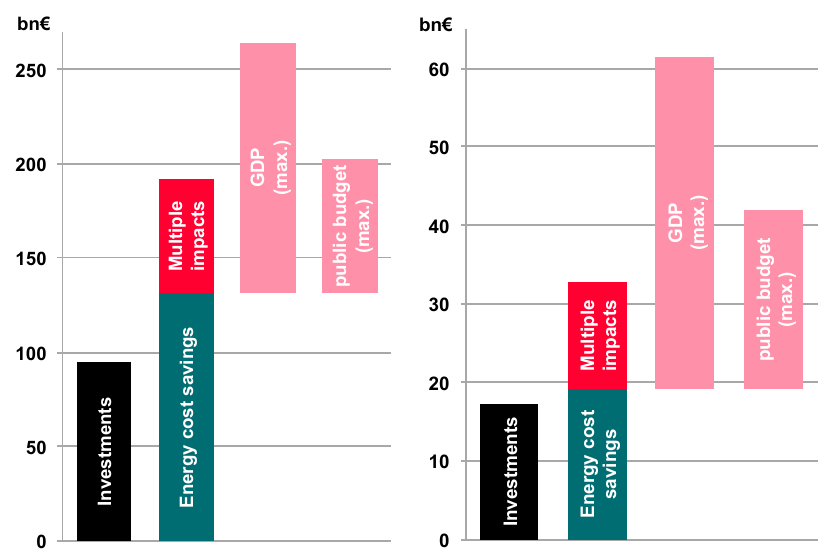
Figure 3. Investments, energy cost savings and multiple impacts (bn€ annual in 2030).